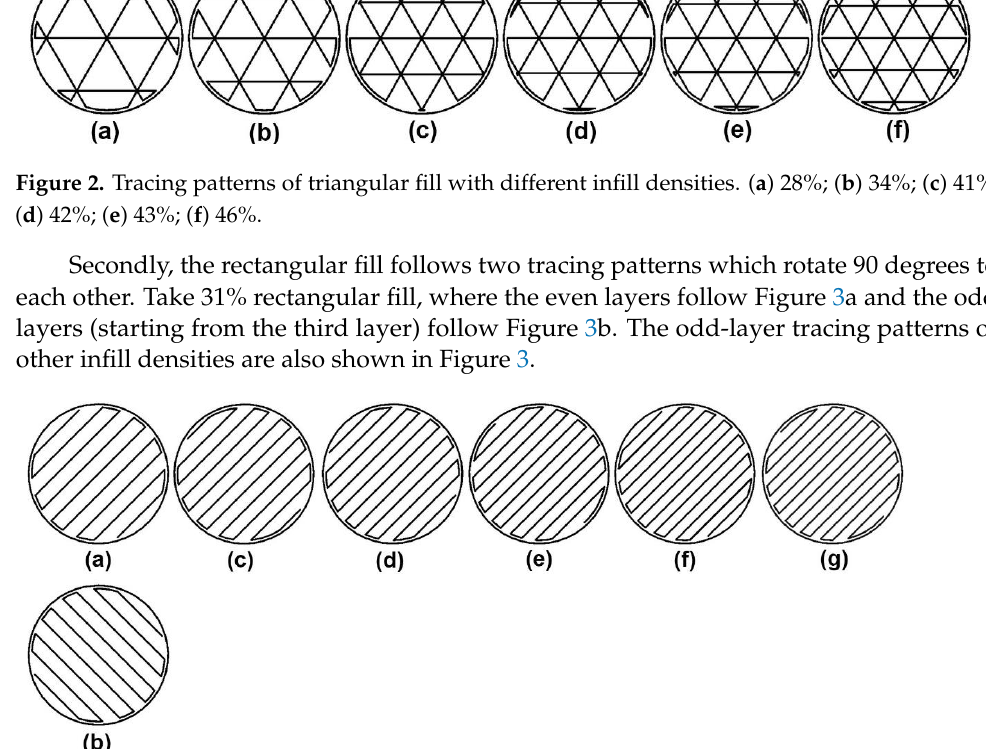
Figure 3. Tracing patterns of rectangular fill with different infill densities. ( a ) even layers for 31%; ( b ) odd layers for 31%; ( c ) odd layers for 35%; ( d ) odd layers for 38%; ( e ) odd layers for 41%; ( f ) odd layers for 45%; ( g ) odd layers for 48%.